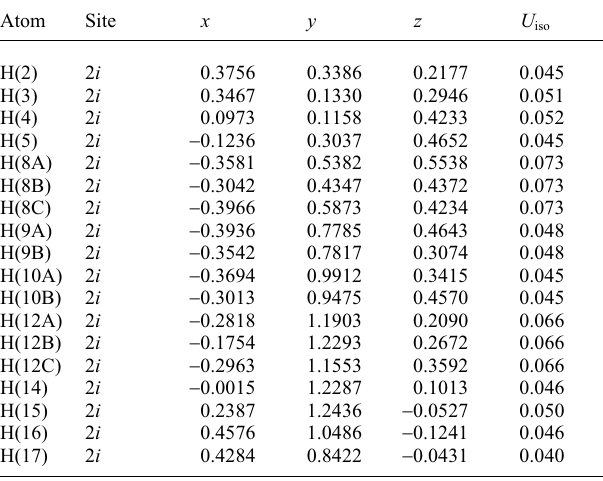
Table 2. Atomic coordinates and displacement parameters (in Å 2 )